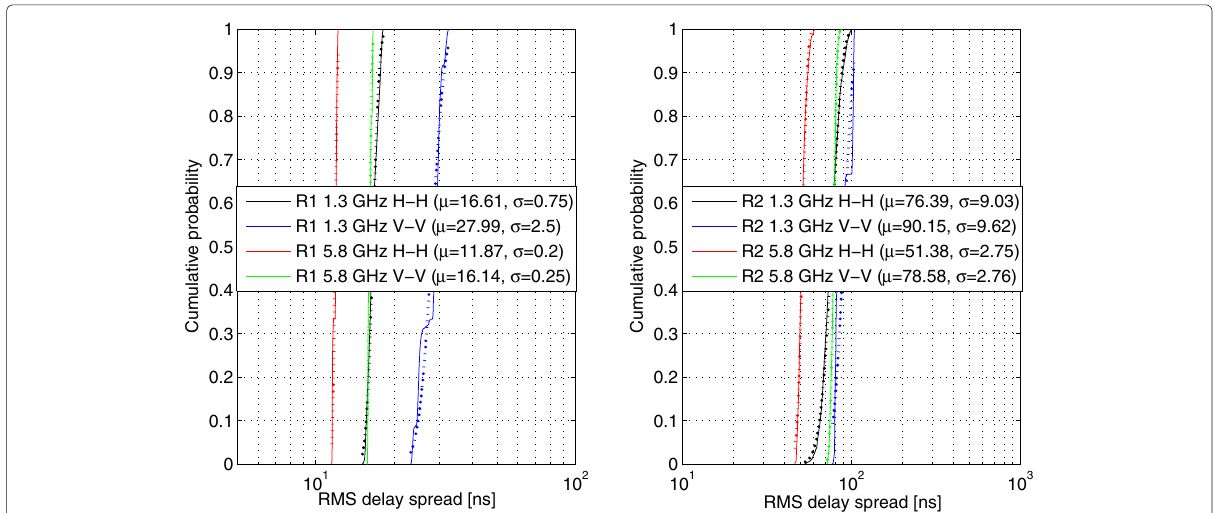
Fig. 9 R1 and R2 root mean square delay spread. Cumulative Distribution Function of the root mean square delay spread in [ns] for different frequencies and both horizontal and vertical co-polarizations of the first and second measurement routes (R1 and R2) in line of sight and non-line of sight scenarios, respectively. The colored dotted lines represent the Normal distribution of the corresponding frequency and polarization